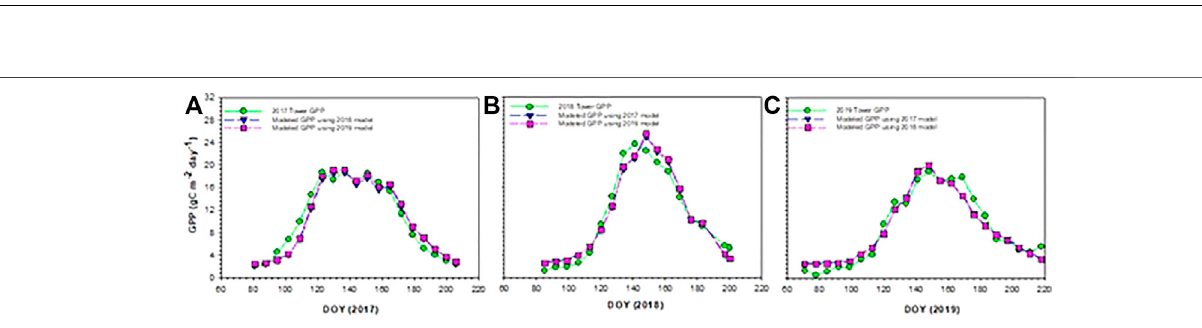
Frontiers in Remote Sensing |